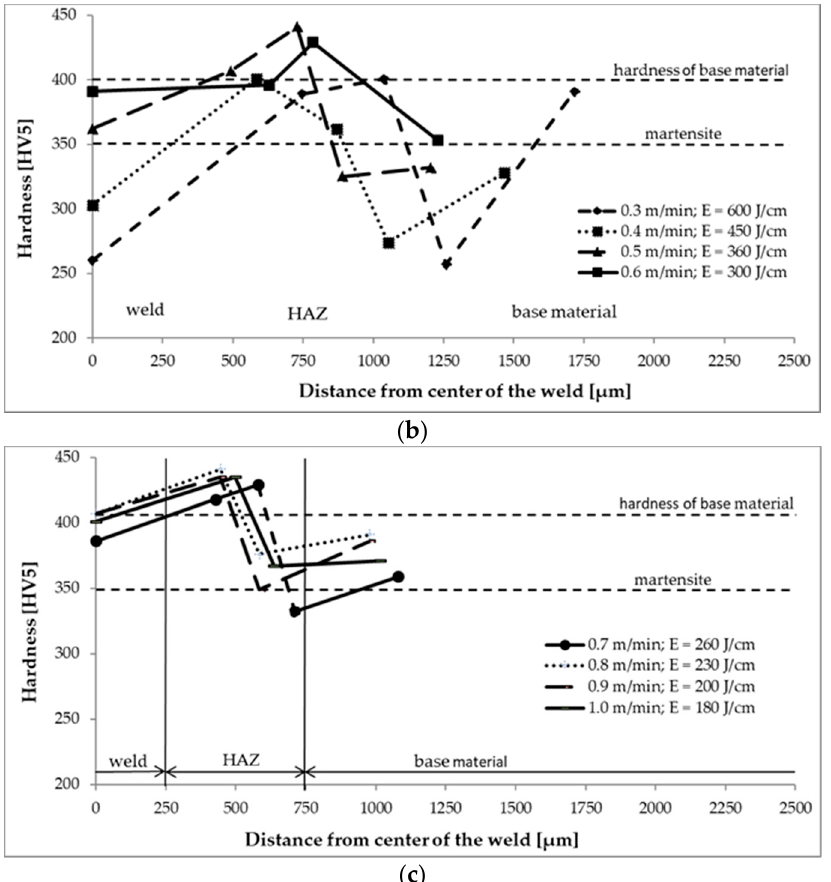
Figure 6. Hardness in direction from the weld centre to the base obtained at welding speeds ( a ) below 0.2 mm/min ( b ) from 0.3 to 0.6 m/min and ( c ) from 0.7 to 1.0 m/min.